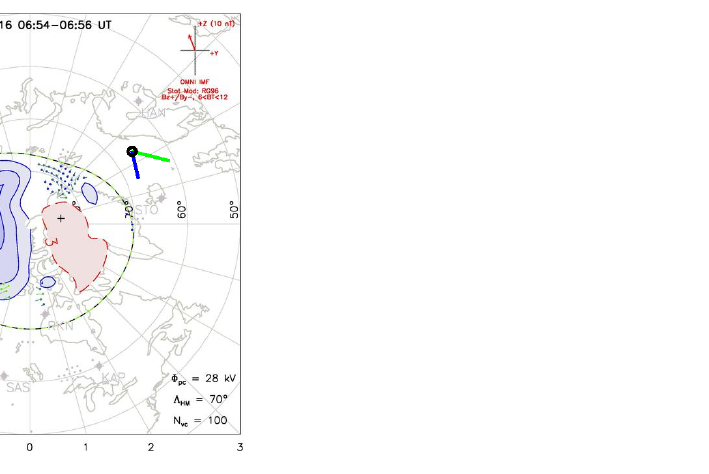
Figure 15. Qualitative caption. comparison of drift estimation by two methods, according to for- mula (12)—green, and formula (20)—blue, with ionospheric convection obtained by the SuperDARN system for moments: marked in Figure 18a,b with green vertical lines, for the quiet time (set L547785); panel ( a ) for 3:54 UT, panel ( b ) for 5:30 UT, and panel ( c ) for 6:54 UT of 2016.09.25.